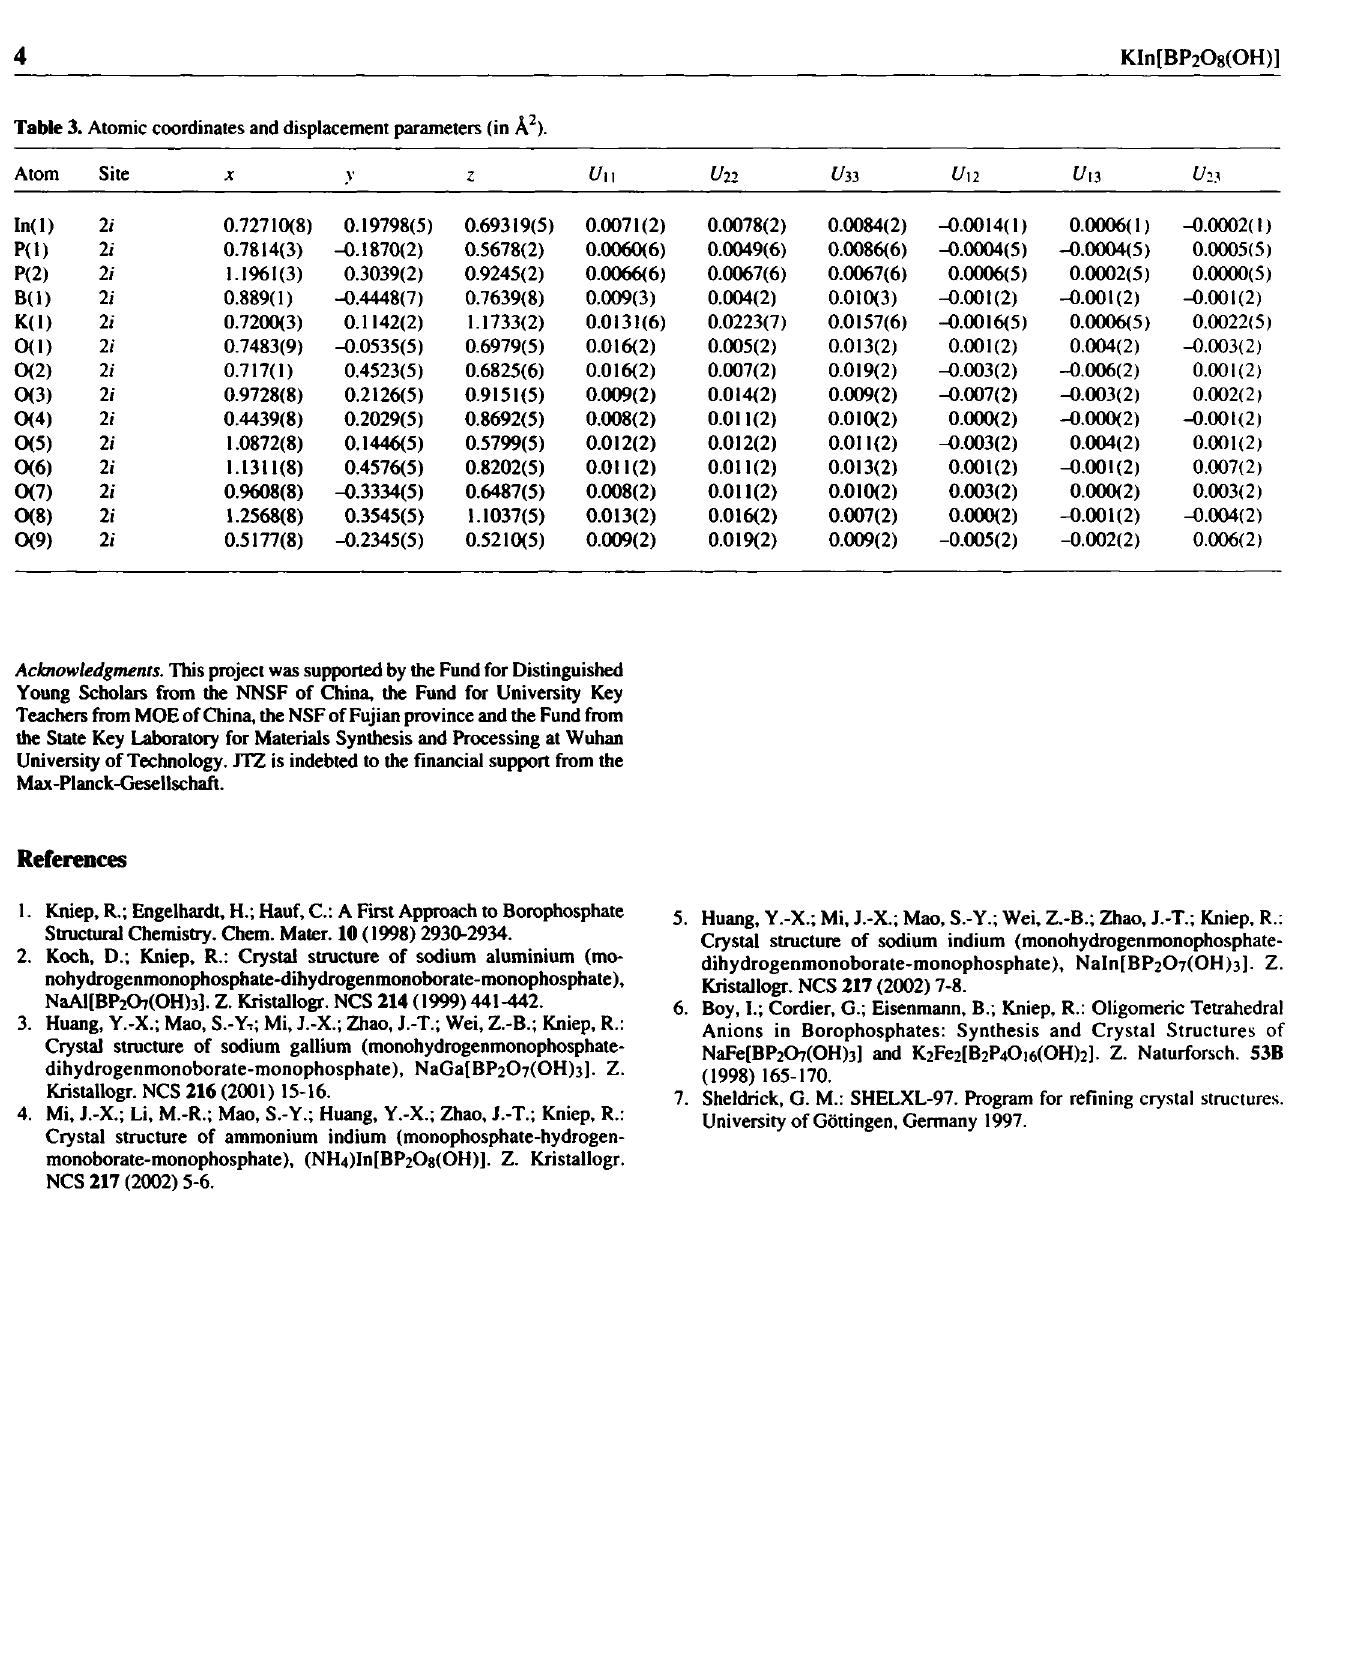
Table 3. Atomic coordinates and displacement parameters (in Â 2